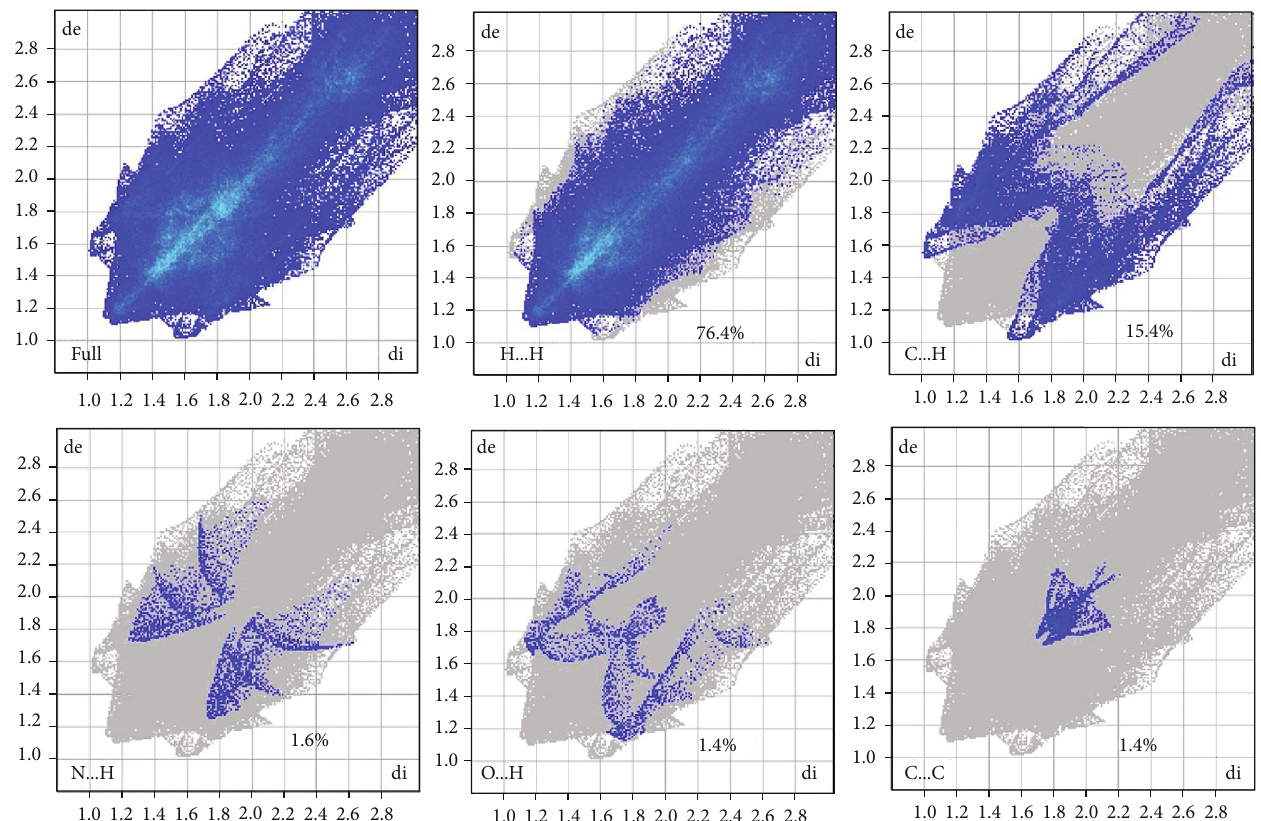
Figure 8: 2D fi ngerprint plots of Cu(H the surface,